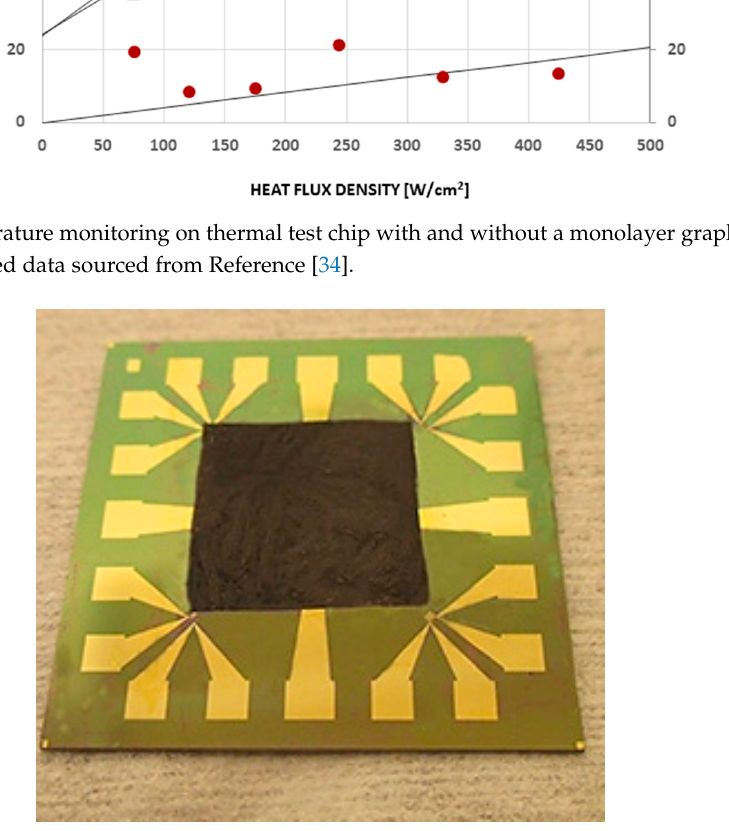
Figure 11. Multilayer transferred graphene film placed on hotspot test structure as a heat spreader across the chip surface.